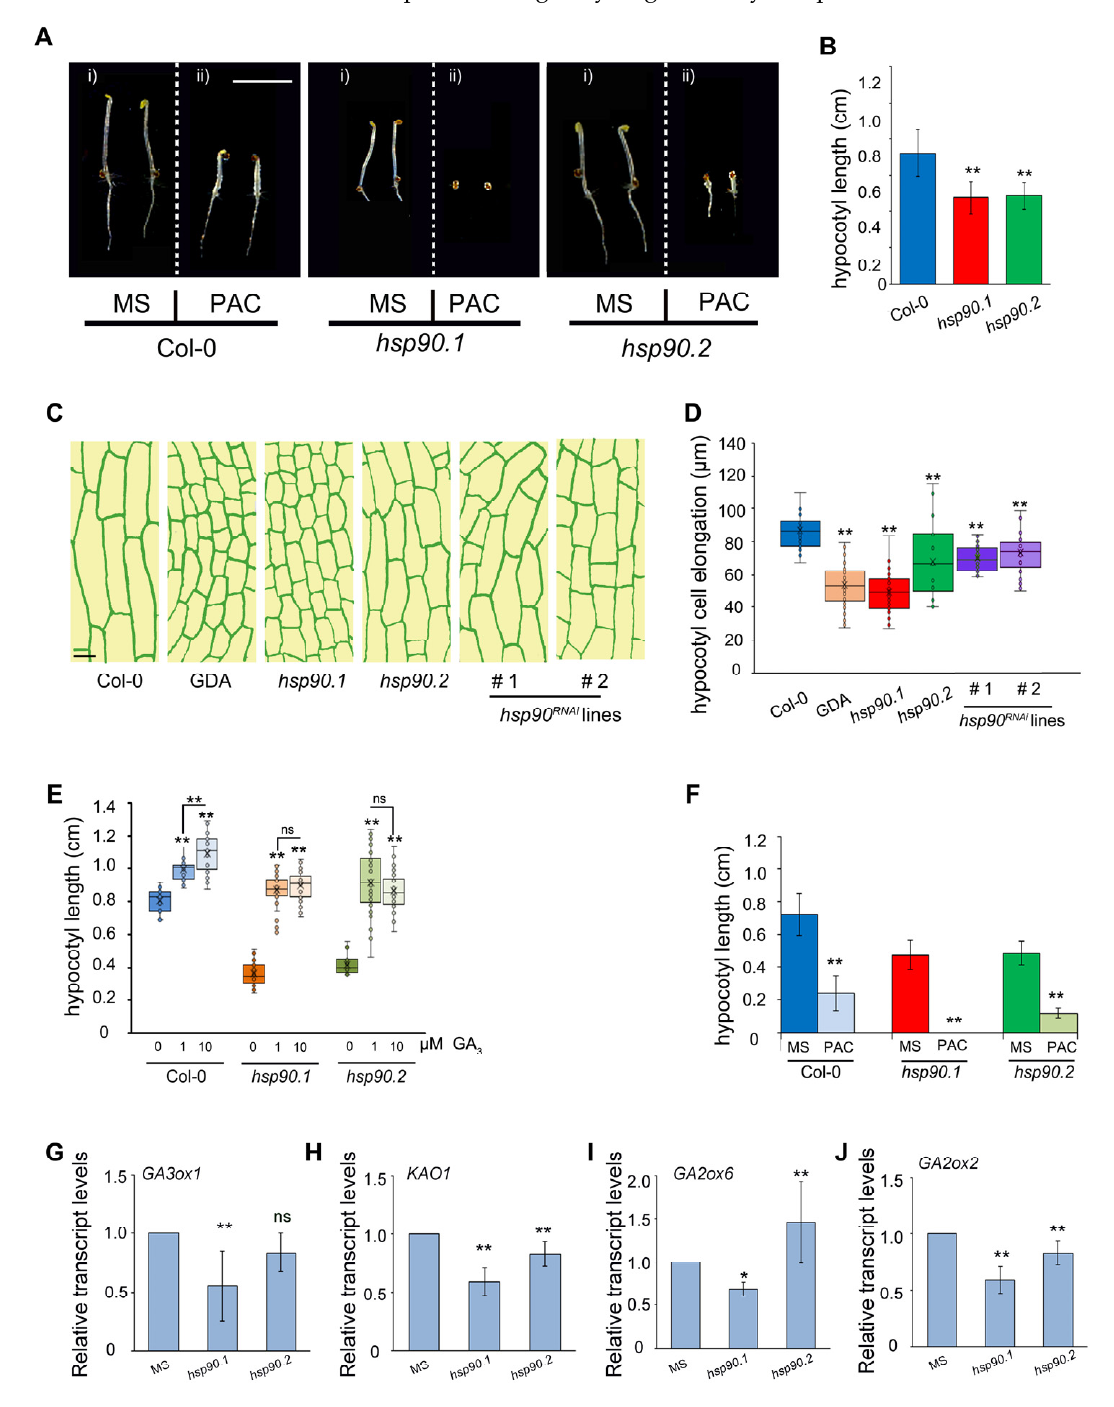
Figure 1. The hsp90.1 and hsp90.2 mutants respond differently to GA in the dark. ( A ) Hypocotyl phenotypes of 5-day-old wild-type (Col-0), hsp90.1 and hsp90.2 etiolated seedlings grown in MS ( i ) or in medium supplemented with 0.1 µ M PAC ( ii ). Scale bars, 0.5 cm. ( B ) Hypocotyl length measurements of seedlings shown in ( Ai ). ( C ) Diagrammatic presentation of hypocotyl